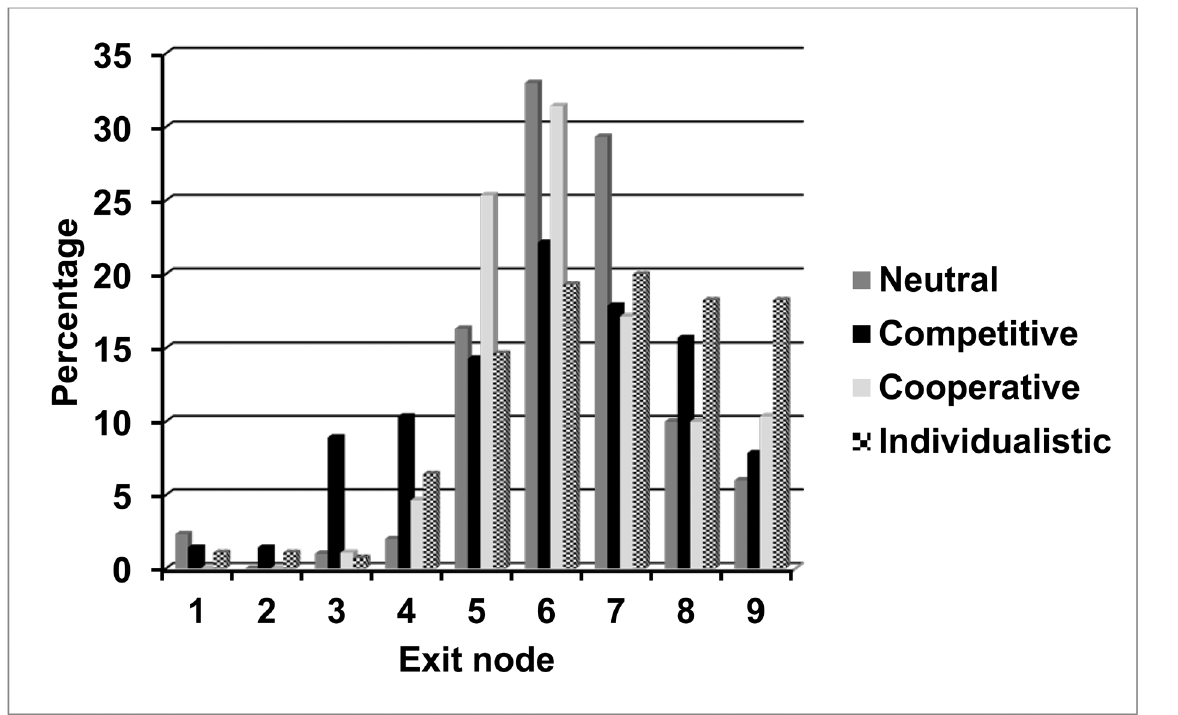
Fig 4. Exit Nodes: Experiment 2. Percentage of games terminating at each exit node in four treatment conditions of Experiment 2.